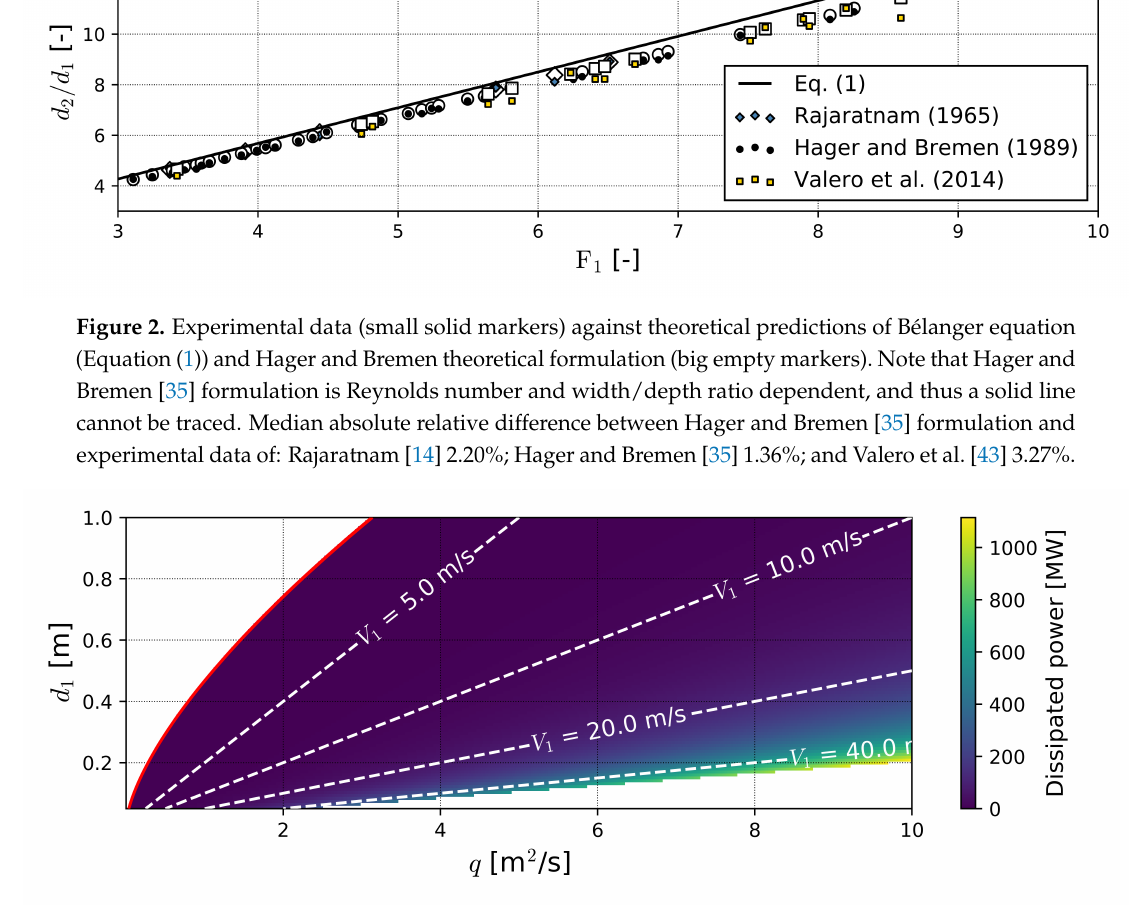
Figure 3. Dissipated energy in a 100 m wide Classic hydraulic jump (CHJ) depending on the inflow conditions: depth and specific flow rate q . Values for F 1 = 1 have been marked with a red solid line. Discharges with V 1 > 50 m/s have been blanked